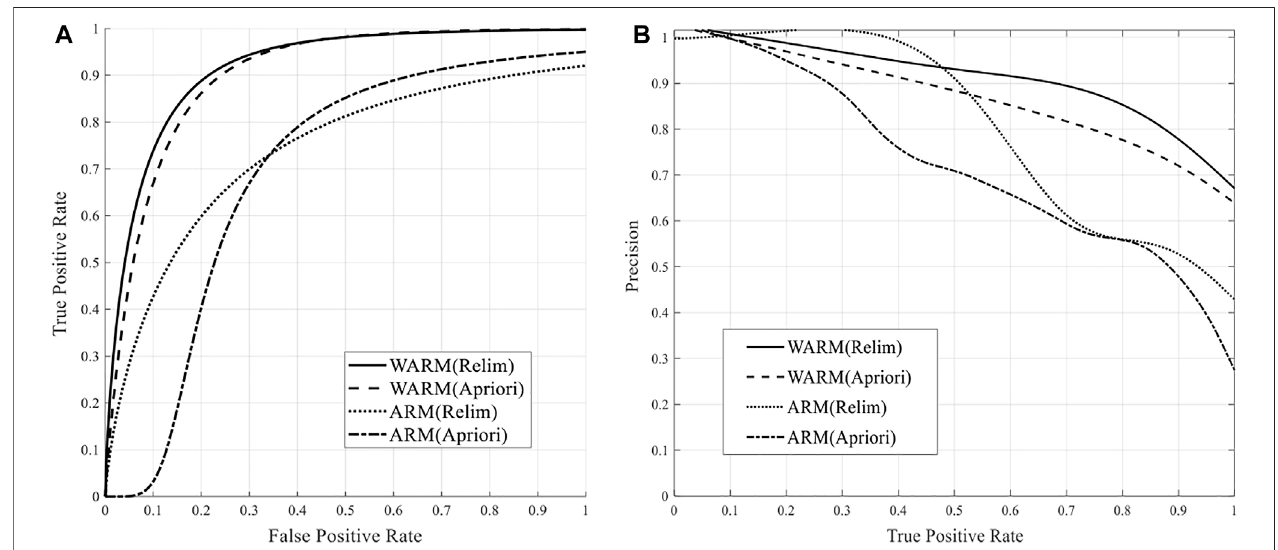
FIGURE 2 | Performance comparison of general case: (A) ROC, (B) PR.